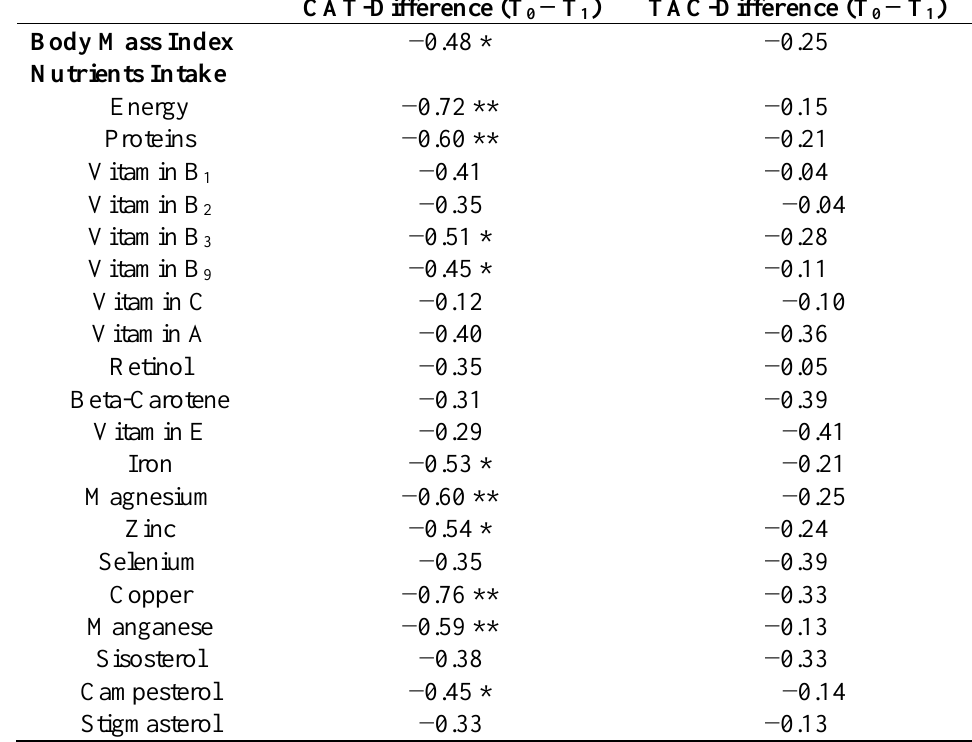
Figure 3. Correlations between body mass index (BMI) and total antioxidant capacity/catalase (TAC/CAT) at T 0 and T 1 . Table 4. Correlations between change in catalase (CAT) and total antioxidant capacity (TAC) and the magnitude of change in antioxidant function-related